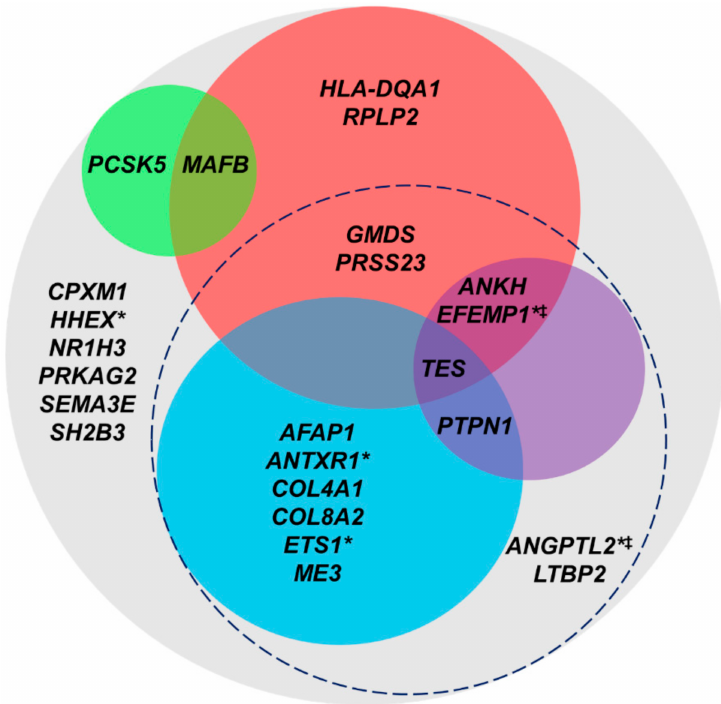
Figure 2. Prioritization of intraocular pressure (IOP)-associated genes differentially expressed in primary open-angle glaucoma (POAG)-affected trabecular meshwork (TM) tissue and/or Schlemm’s canal (SC) cells. Twenty-four IOP-associated genes were differentially expressed (|FC| ≥ 1.5) in POAG-affected TM tissue and/or POAG-affected SC cells (grey circle). Fifteen of the 24 genes were highly expressed (FPKM ≥ 10) in non-glaucomatous TM or SC cells (dashed circle), all of which were located in regions of histone modification. Eight of the IOP-associated variants in/near these 15 genes were located in enhancer or promoter regions (blue circle), and 4 of the 15 were significantly/highly expressed in TM tissue (purple circle). Eight of the 24 genes were specifically expressed in ≥ 1 cell cluster defined by single-cell RNA-sequencing of human outflow tissue (red circle), and 2 of the 24 genes were differentially expressed by cyclically stretched human TM cells (green circle). Five of the 24 genes were part of differential correlation pairs (asterisk) and 2 were regulated by ESR1 (two-barred